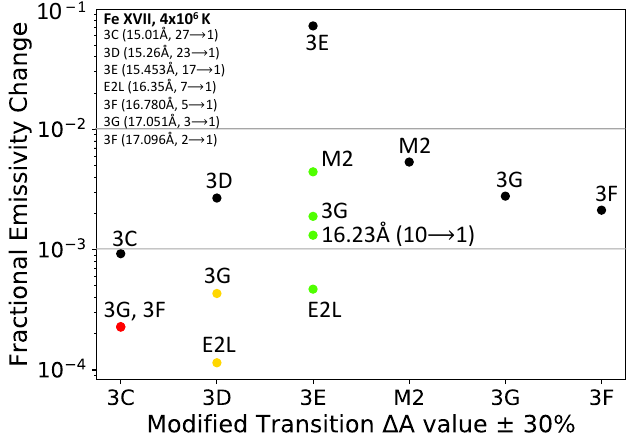
30% change in A value at ±